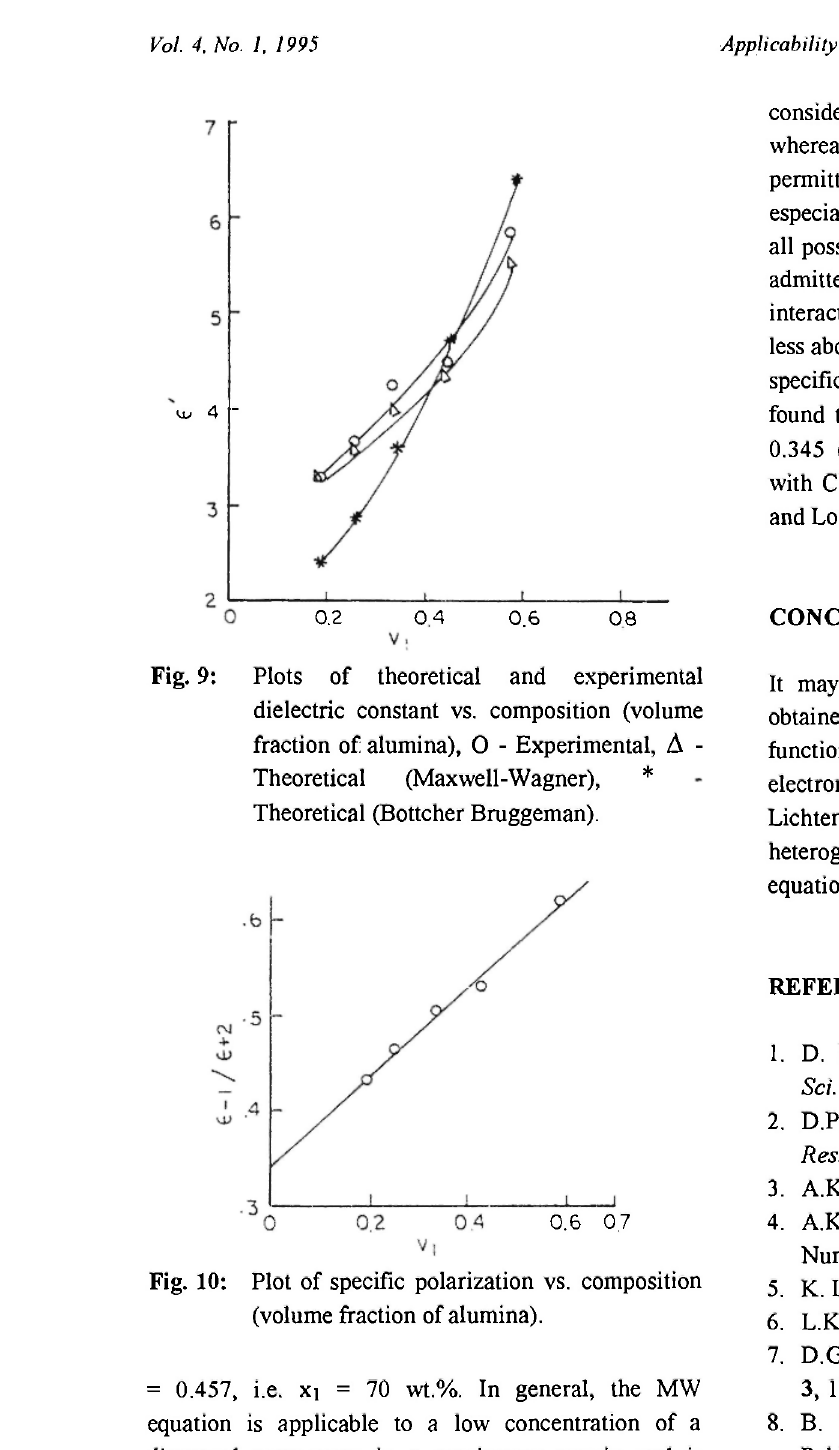
Fig. 10: Plot of specific polarization vs. composition (volume fraction of